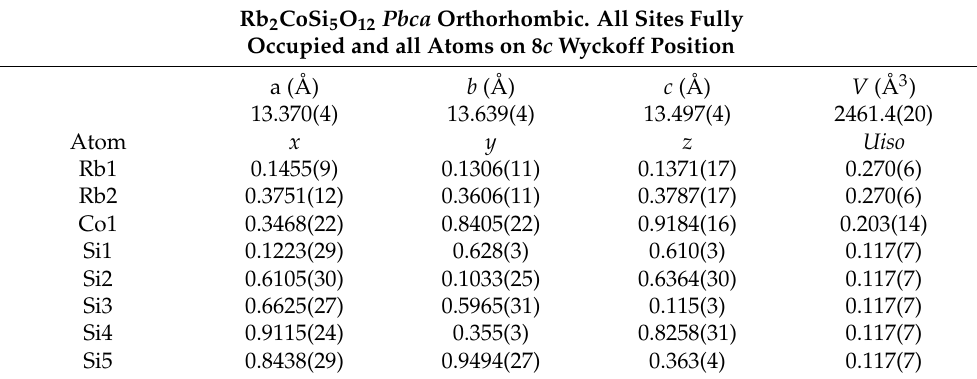
Figure 1. Ambient temperature Rietveld difference plot for Rb 2 CoSi 5 O l2 . Blue dots show observed data, red line shows calculated data, black line shows difference plot and black diamonds show positions of Bragg reflections. Table 1. Refined atomic coordinates for ambient temperature Rb 2 CoSi 5 O l2